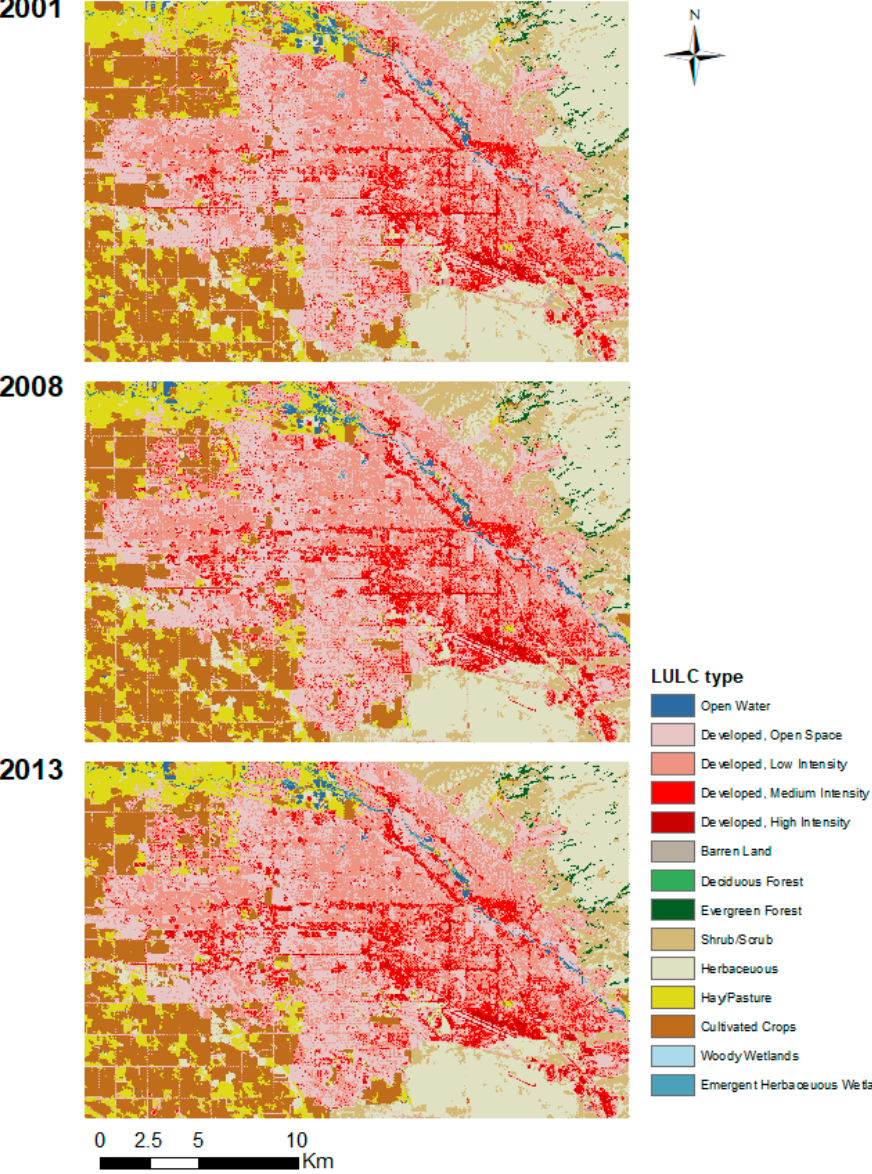
Figure 2. Land use land cover (LULC) maps of the Boise-Meridian metropolitan area for 2001, 2008, and 2013.